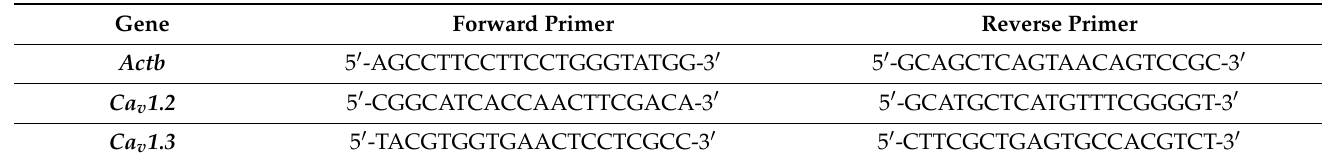
Table 1. Primer sequences used in reverse transcription polymerase chain